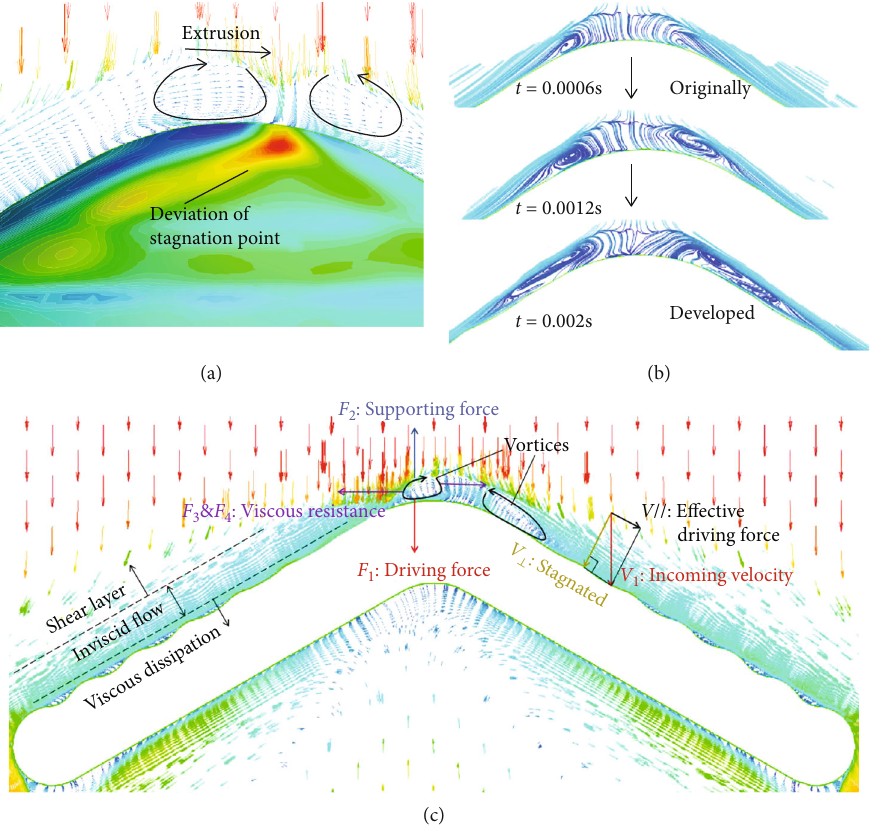
Figure 11: Velocity vectors and force analysis of vortex at the initial stage: (a) velocity vectors; (b) development process; (c) force